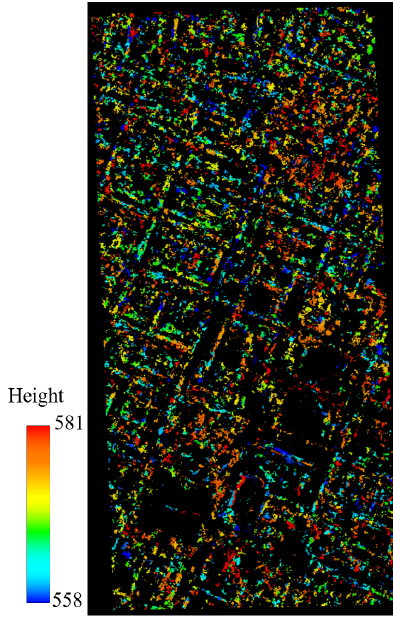
Figure 3. The point cloud reconstructed from TerraSAR- X/WorldView-2 images over the Munich city.